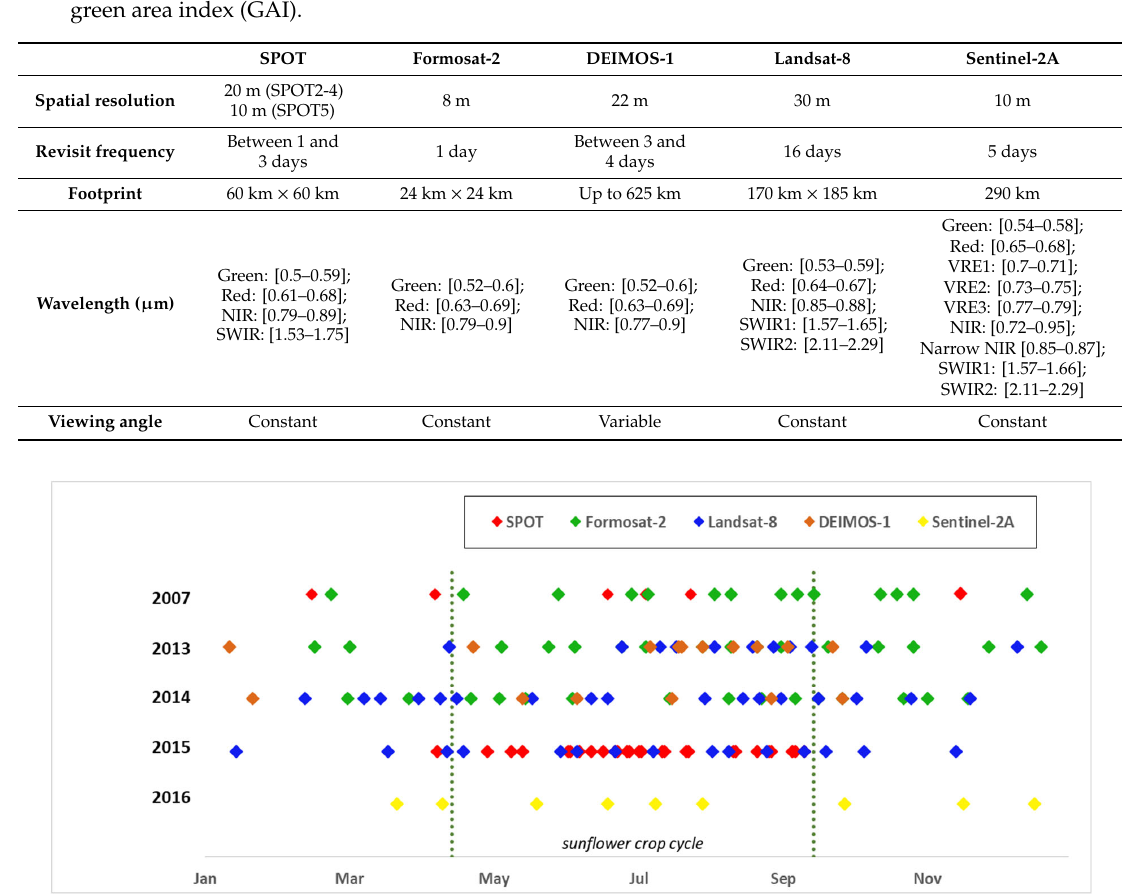
Figure 3. Timeline of images for each year of study and each sensor.